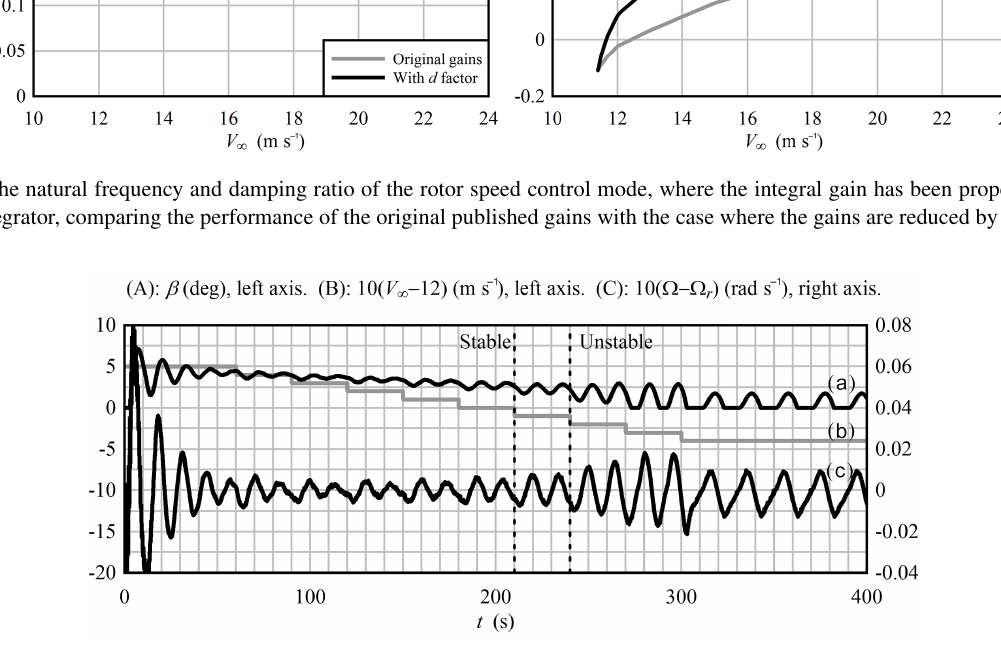
Figure 13. A FAST v8/BeamDyn time-domain analysis of the NREL 5 MW turbine with baseline controller, showing unstable behavior at wind speeds below 11.9ms − 1 . The amplitude of the unstable behavior is bounded by nonlinearities: the control mode transition on one side and a stable region, existing because of gain scheduling, on the